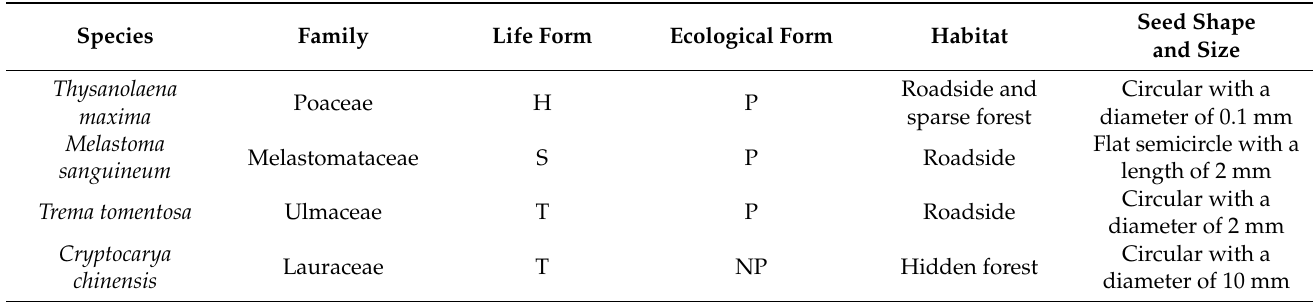
Table 1. Main characteristics of the species used in this study.